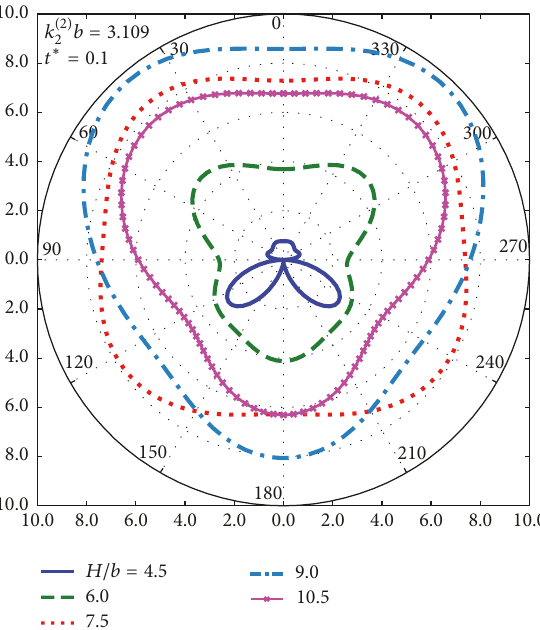
Figure 15: Tangential stress (𝜎 ∗ 𝜃𝜃 ) versus polar angle at 𝑟 = 𝑏 for different depths (𝐻/𝑏) for a tunnel in soft soil.